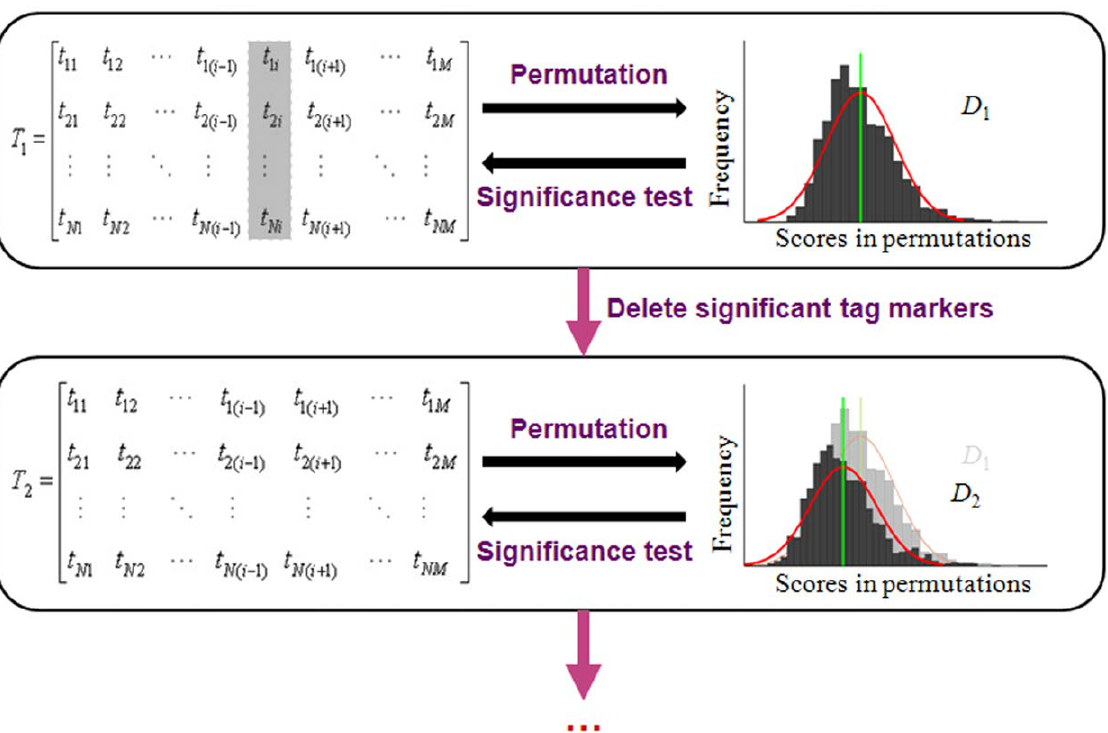
Figure 2. Procedure of peel-off permutation and significance test. It starts from the tag marker data matrix T ( N 6 M ), and generates null distribution D 1 through permutations on the data. Based on D 1 , significance level is assigned to each tag marker. If the significance level is less than a cutoff ( e.g. 0.05), the corresponding markers ( e.g. the i -th tag marker) will be removed from the matrix in the next iteration of permutation and significance test. This procedure is continuing until achieving a null distribution D H , based on which there are no additional tag markers are identified significant. In this procedure, the mean of the null distribution moves left gradually, e.g. in the second iteration, D 2 moves left when compared with D 1 .